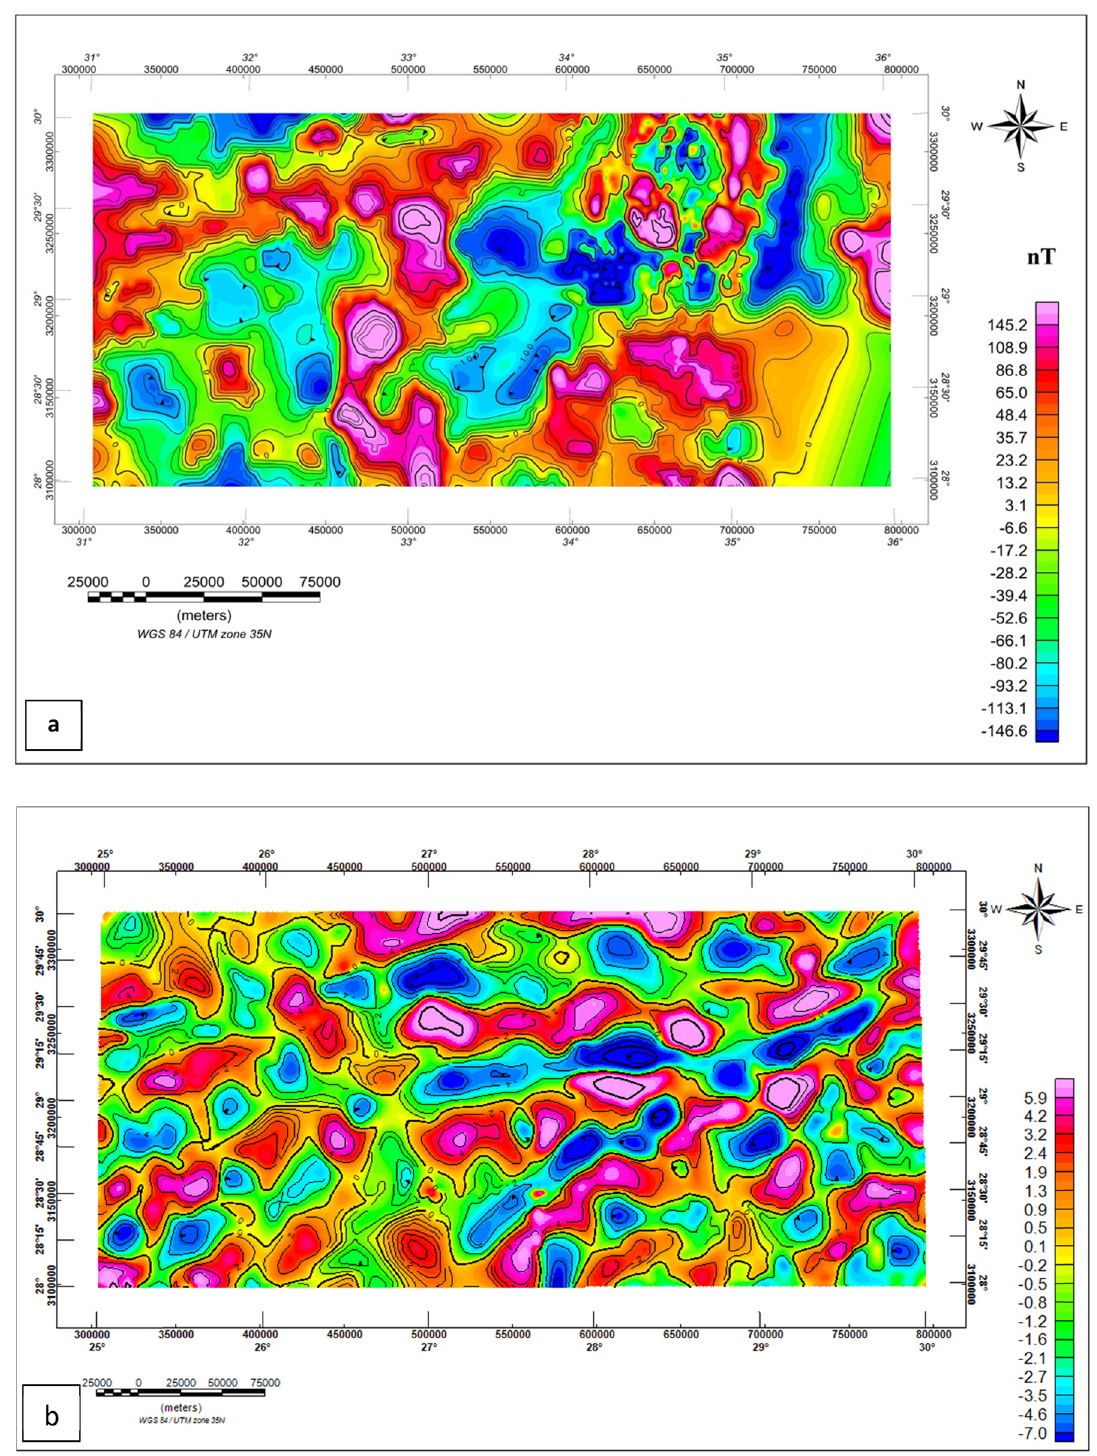
Figure 11: ( a ) Residual and ( b ) high pass fi lter of the magnetic